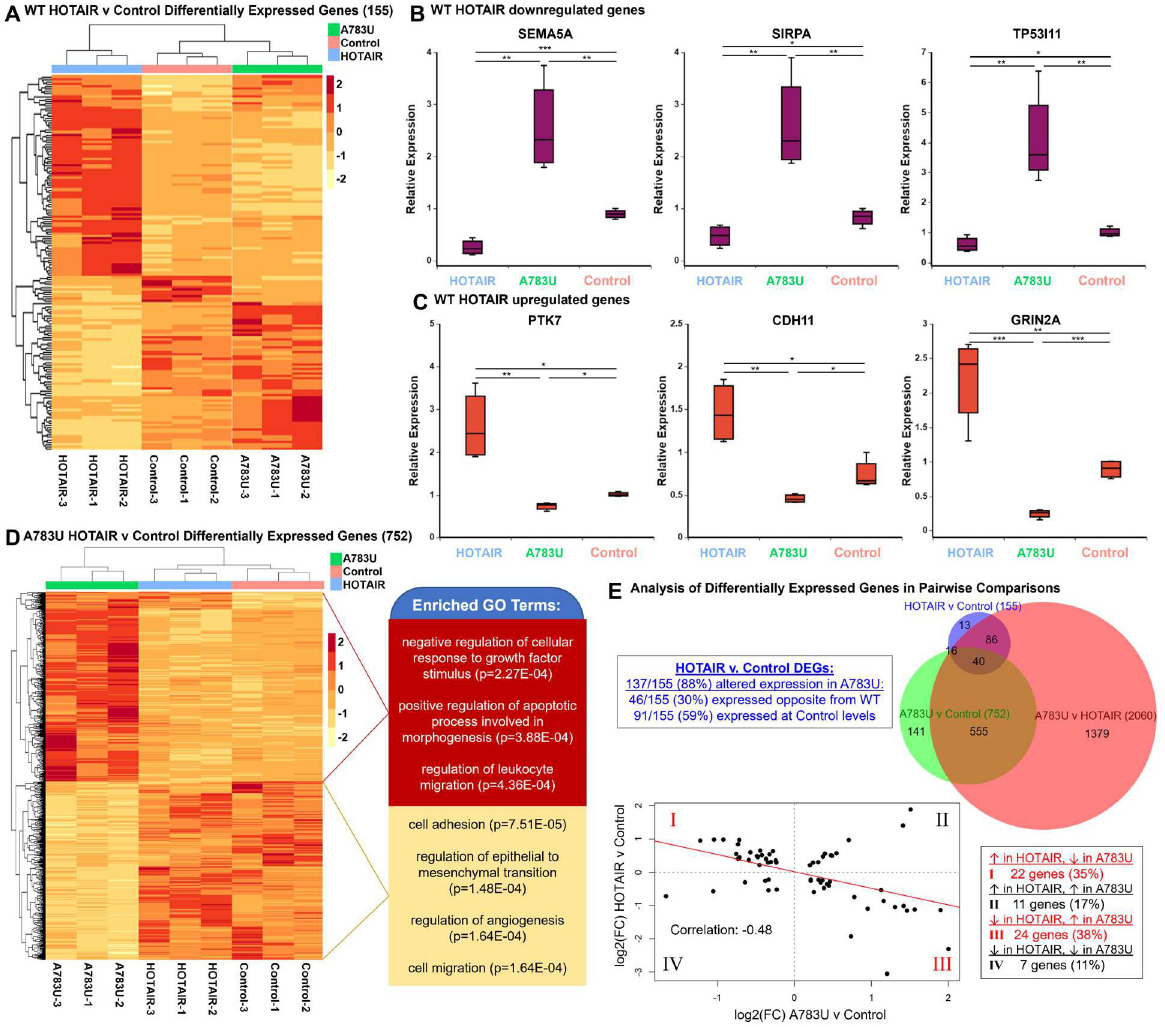
Fig 5. HOTAIR-mediated gene expression changes in breast cancer are altered by mutation of A783. (A) Heat map of Z-scores of DEGs between MDA-MB-231 cells overexpressing WT HOTAIR versus an Anti-Luciferase control. (B, C) qRT-PCR analysis of genes up-regulated (B) or down-regulated (C) upon HOTAIR overexpression. (D) Heat map of Z-scores of DEGs between MDA-MB-231 cells overexpressing A783U mutant HOTAIR versus an Anti-Luciferase control, left. Selected significant GO terms in up-regulated (red) and down-regulated (yellow) genes, right. (E) Additional analysis of DEGs. Top, Venn diagram (created using BioVenn [66]) of number of DEGs between MDA-MB-231 cells overexpressing WT HOTAIR, A783U mutant HOTAIR, or an Anti-Luciferase control. Top left inset describes the direction of change in A783U v. Control relative to the direction of WT HOTAIR v. Control, based on adjusted p < 0.1. Bottom, correlation analysis of expression in HOTAIR vs. Control and A783U vs. Control pairwise comparisons. Linear regression was used to fit a trend line (red) over the points representing DEGs in HOTAIR vs. Control, Pearson correlation coefficient included. Bottom right inset describes the number of genes in each quadrant. Numerical values in panels 5B–C, 5E are included in S2 Data. DEG, differentially expressed gene; WT, wild-type.